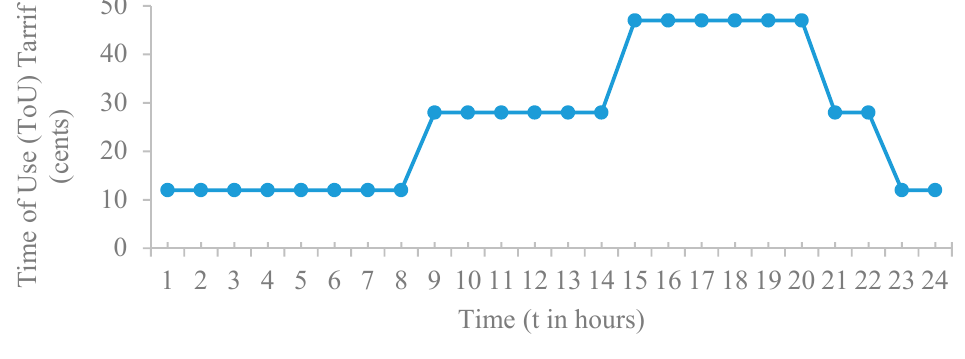
Figure 15. Applied Time of Use (ToU) electricity tariff [68].